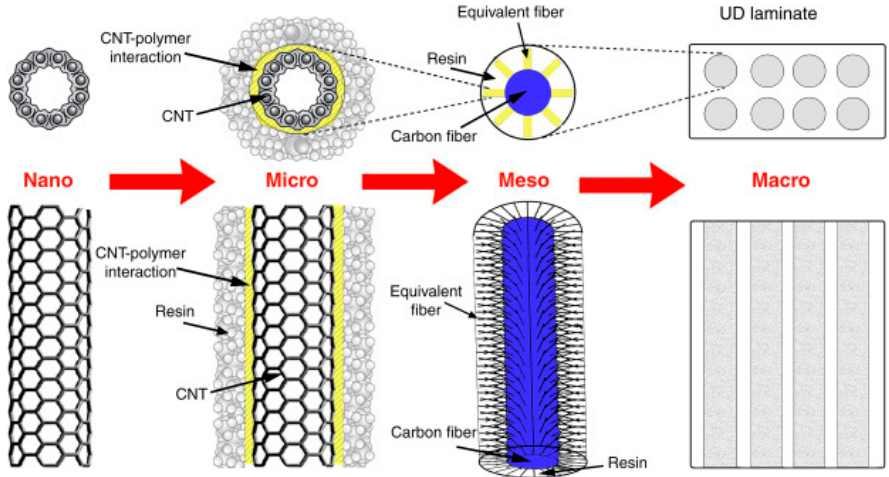
Figure 7. An image of carbon fiber with carbon nano tube reinforcement [63].